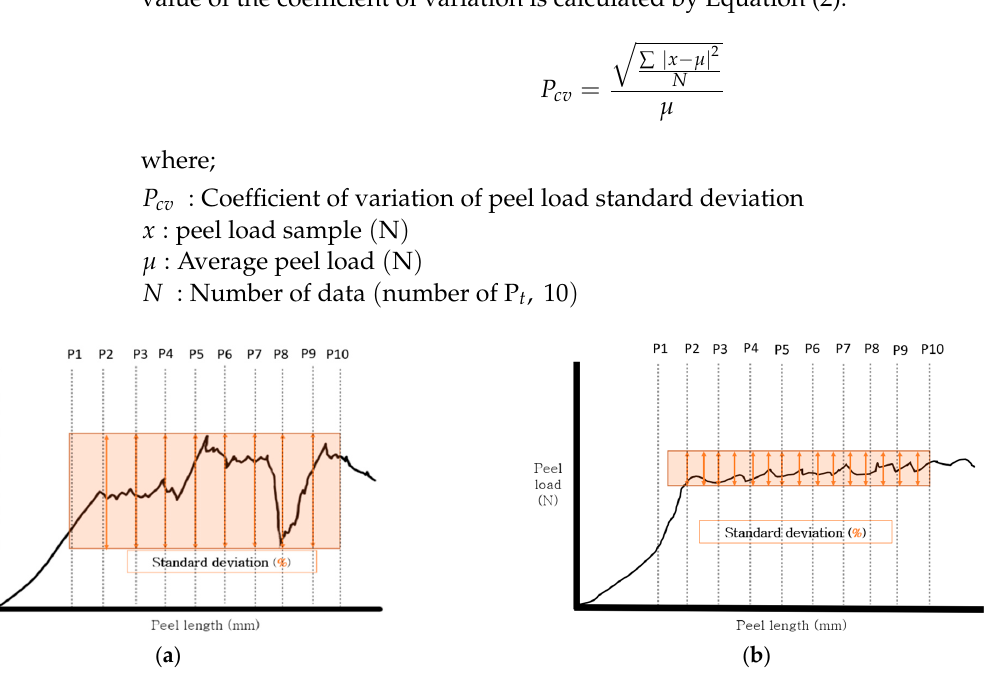
Figure 9. A stability analysis comparison example of peel load data standard deviation; ( a ) a case with high standard deviation, ( b ) a case with low standard deviation.